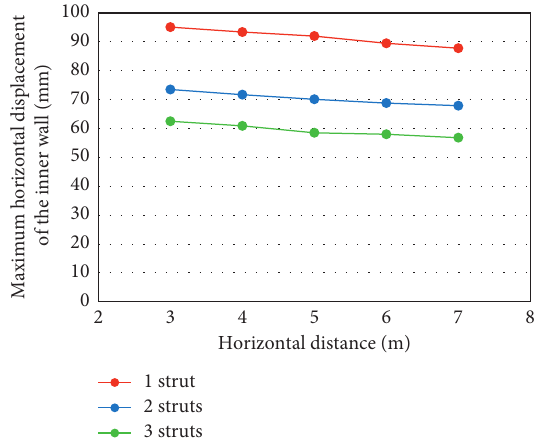
Figure 9: Relationship between the horizontal distance and the maximum horizontal displacement of the inner wall.